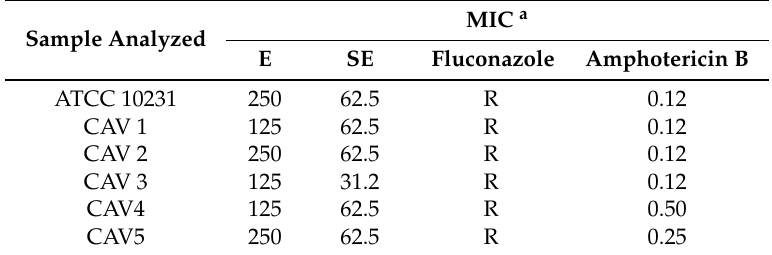
Table 3. Minimum Inhibitory Concentration (MIC) of E and SE against Candida albicans ( C. albicans ). MIC a Sample Analyzed E SE Fluconazole Amphotericin B ATCC 10231 250 62.5 0.12 ATCC 10231 250 62.5 125 62.5